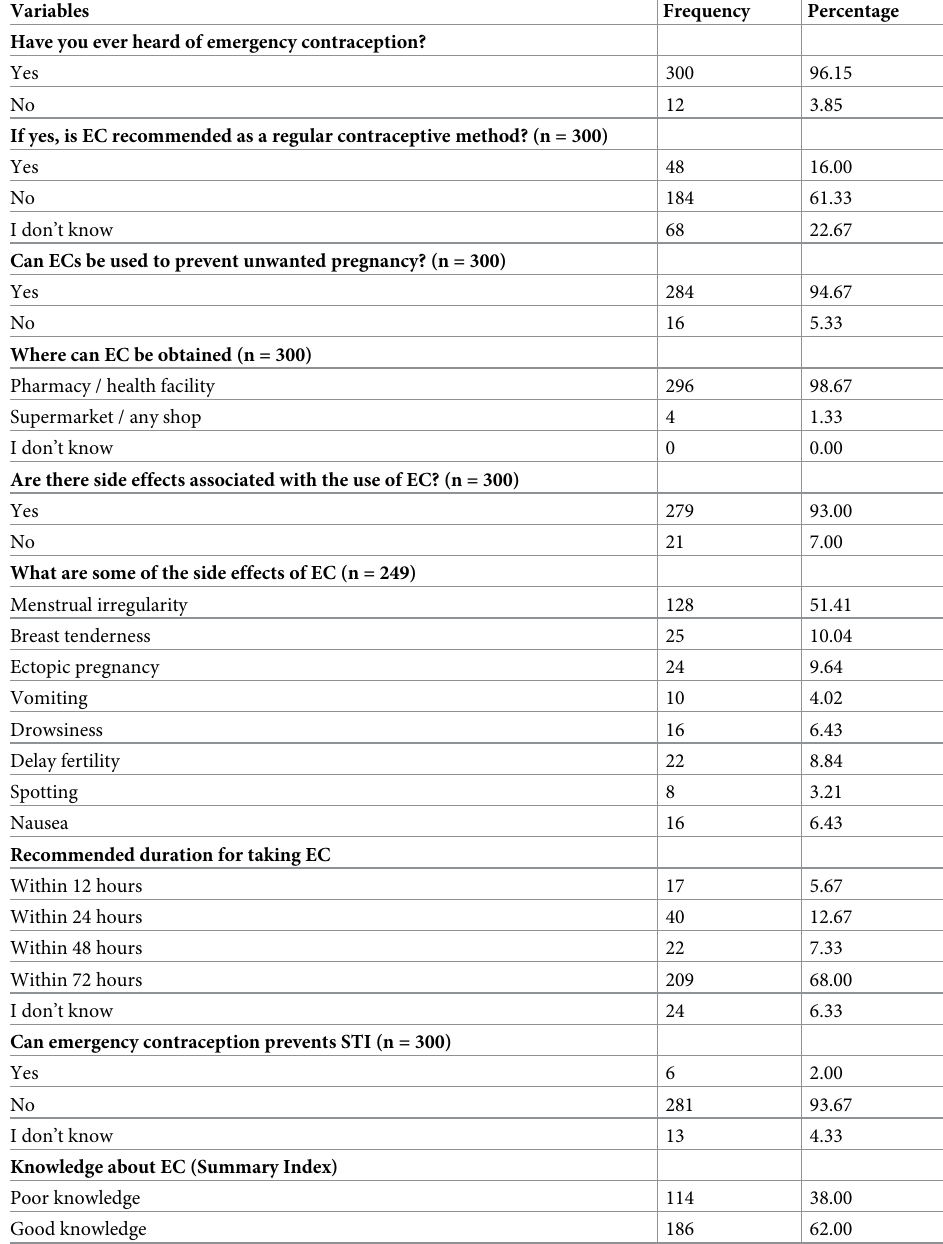
Table 2. Respondents’ knowledge about emergency